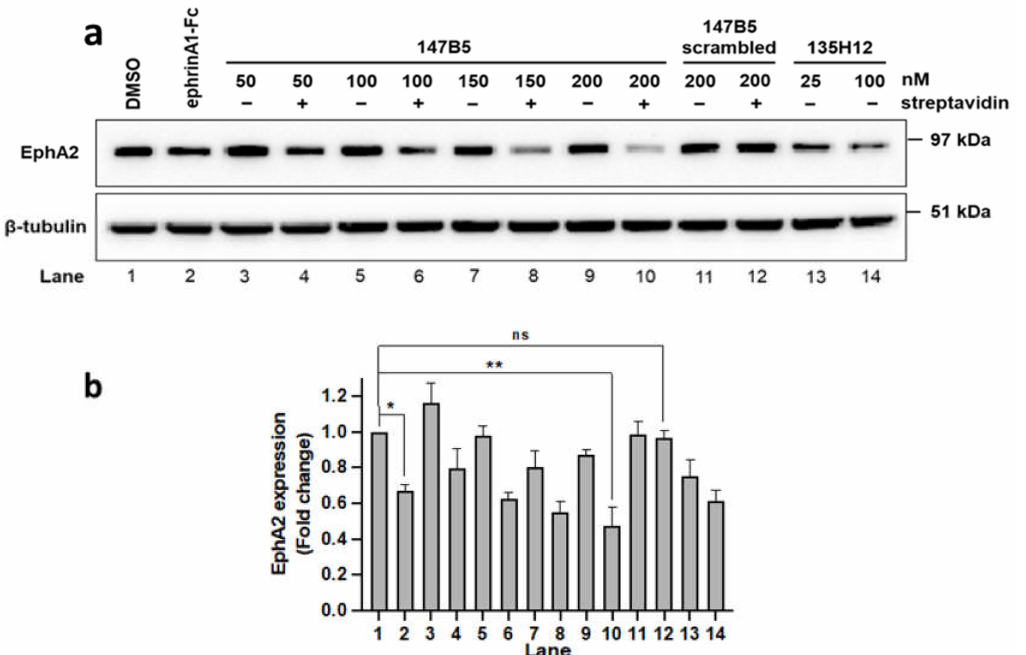
Figure 3. Effect of 135H11-biot (147B5, Table 1), and its complexes with streptavidin at various ratios, on EphA2 receptor degradation. ( a ) Western blot of MDA-MB-231 cells treated (1 h) with ephrinA1-Fc, EphA2 agents 135H12 (135H11 synthetic dimer; tested at 50 nM and 200 nM monomer concentration), and 147B5 (50 nM to 200 nM) and its scrambled-biot corresponding compound (200 nM) (Table 1), tested in the absence and presence of streptavidin (50 nM) for 1 h. Anti-EphA2 blot suggests that the positive control ephrinA1-Fc (22 nM monomer) treatment led to significant degradation of the EphA2 receptor, similar to (147B5) n -streptavidin when n = 3 or 4 (150 nM or 200 nM 147B5 concentration in the presence of 50 nM streptavidin) but not when n = 1. ( b ) Densitometry analysis based on duplicate measurements of band intensities relative to the bands of DMSO-treated cells. * p ≤ 0.05, ** p ≤ 0.01 as determined by a one-way analysis of variance using Dunnett post-test analysis. Uncropped images for the WB are available as supplementary